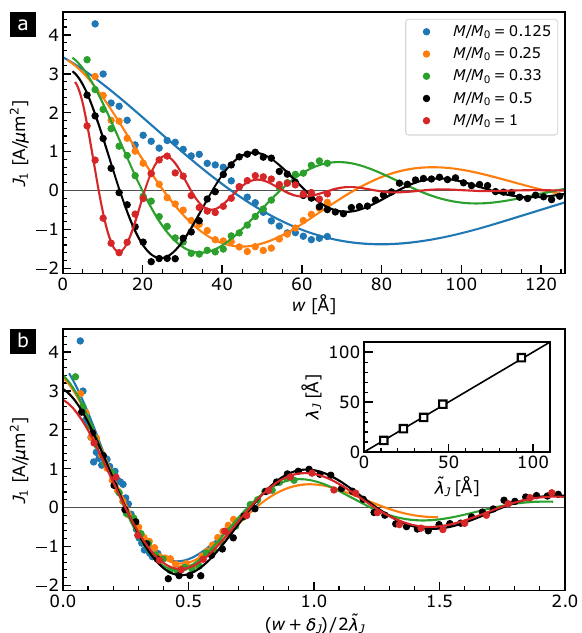
Fig. 10 Magnetic moments rescaling. J 1 for different rescaling of the magnetic moments M / M 0 as a function of a the thickness, w , and b the rescaled thickness, ð w þ δ J Þ = 2 parameter in Eq. (6) and circles; corresponding fi ttings J fit color. (Inset) Half-period, λ J , fi tted using Eq. (6) vs.